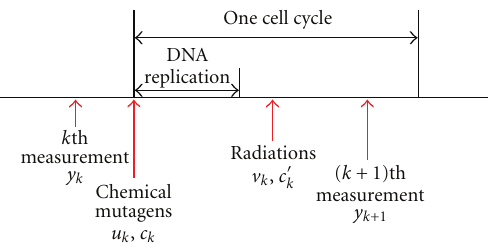
Table 2: Multiplication table for { 1,2, − 2, − 1,0 } .